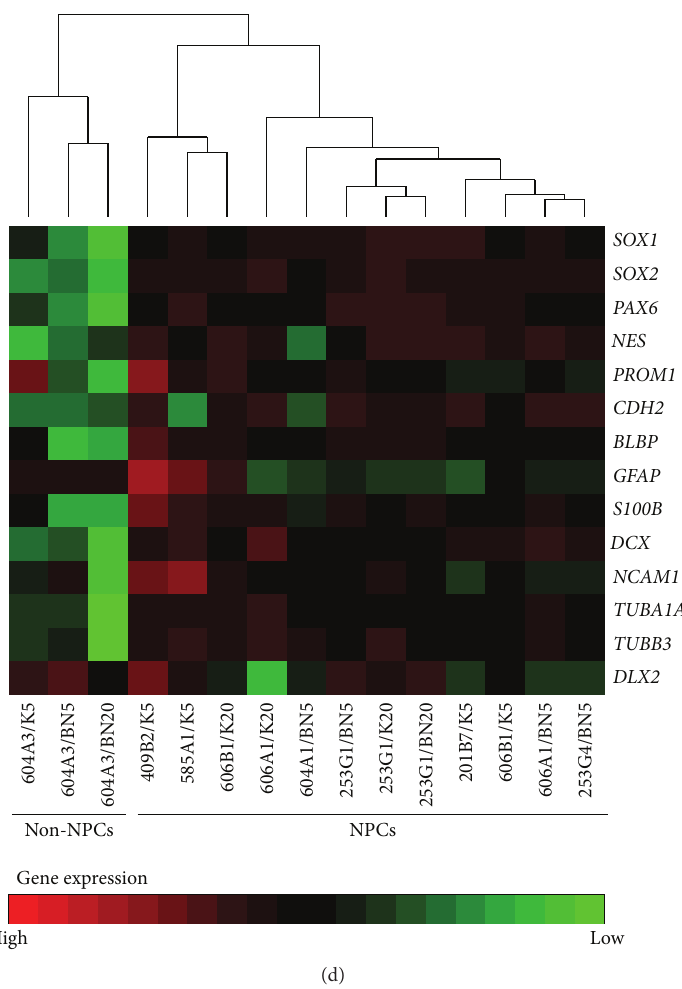
Figure 4: Established hNPCs express regional markers indicative of a mid/hindbrain-type property. (a) Morphologies of the expanded neurospheres at approximately passage 6 (upper panel). 𝛽 III tubulin-positive neurons after 14 days of neuronal differentiation. Green: 𝛽 III tubulin;blue:nucleus(lowerpanel).Scalebars:500 𝜇 m(black)and50 𝜇 m(white).(b)Neuriteanalysisafter14daysofneuronaldifferentiation. Relative total neurite length is shown as the mean ± SD. Statistical analysis was performed using Dunnett’s test. ∗ 𝑝 < 0.05 and ∗∗ 𝑝 < 0.01 . (c) Dot plots and box plots showing the expression of forebrain markers ( FOXG1 and OTX1 ), mid/hindbrain markers ( EN1 and GBX2 ), and a spinal cord marker ( HOXC6 ) in day 14 (D14) neural aggregates and neurospheres at approximately passage 6 (P6). The numbers of clones analyzed are shown in parentheses. Statistical analysis was performed using Welch’s two-sample 𝑡 -test. ∗∗ 𝑝 < 0.01 . (d) Hierarchical clustering of clones based on neural progenitor marker expression. Red: high gene expression; green: low gene